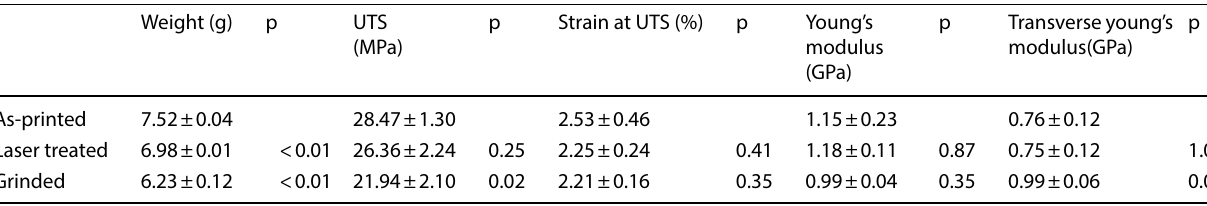
Table 2 Summary of weight and tensile test